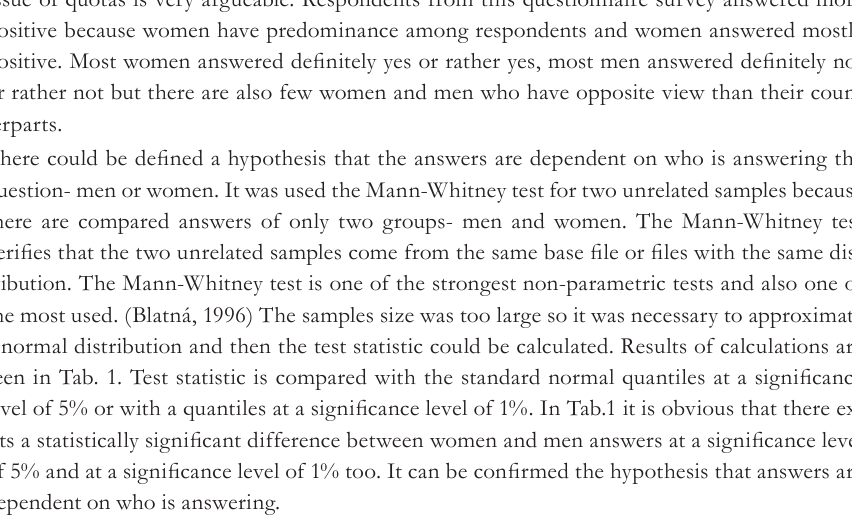
Tab. 1 - Results of calculations of Mann-Whitney test. Source: own processing, 2013. Test statistic (U 0